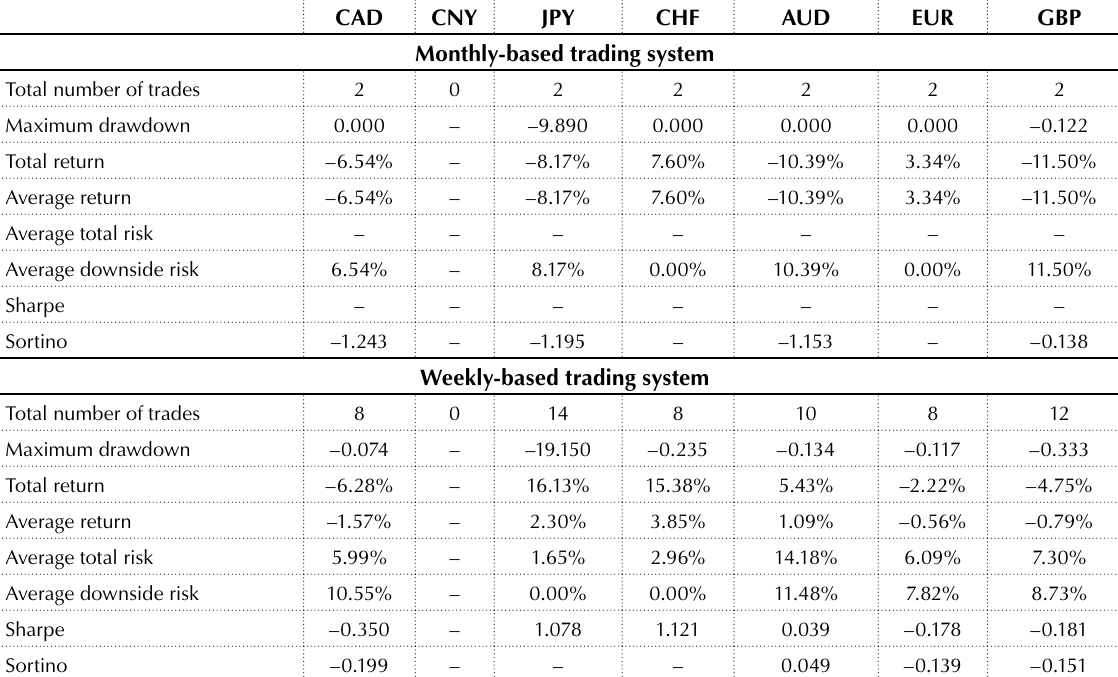
Table 2. Pre 2008 financial crisis